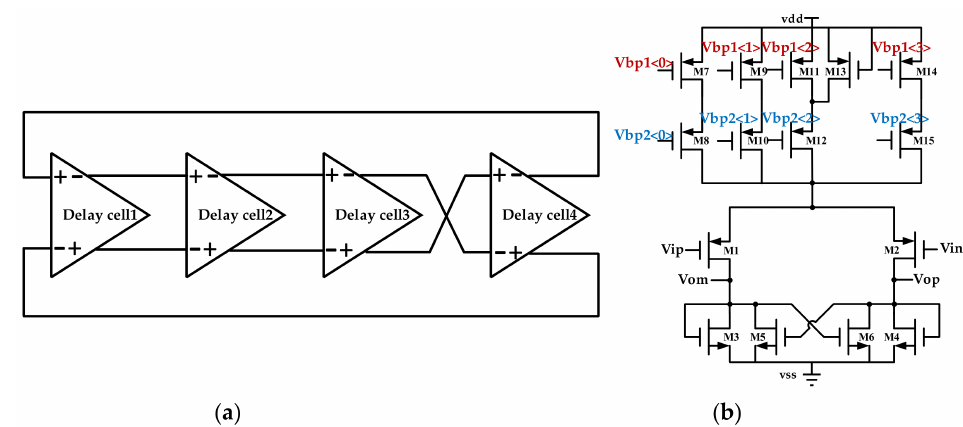
Figure 9. ( a ) Four-stage differential ring oscillator; ( b ) differential cross-coupled delay cell with multiband option.